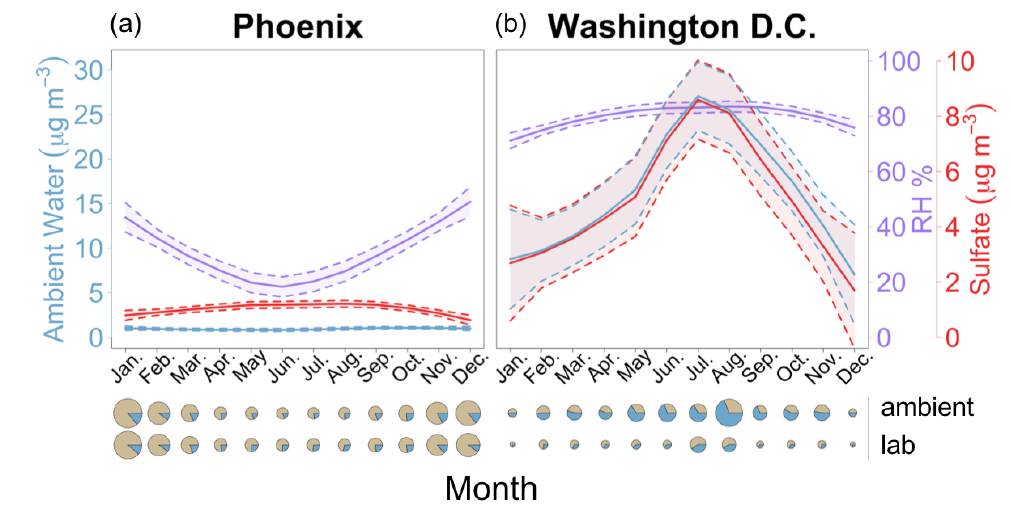
Figure 3. Mass concentrations of aerosol liquid water and particulate sulfate are abundant and positively associated in Washington D.C., and not Phoenix, AZ in 2004. 2004 monthly mean values of ambient water content, relative humidity, and sulfate ( a ) (left) Phoenix, Arizona, and ( b ) (right) Washington D.C. Each variable is presented as the mean (solid line) and 95% confidence interval (shaded area and dotted lines). Pie charts illustrate the monthly average dry mass (brown) and water fractions (blue) for each month in each city at ambient and lab conditions. Pie chart diameter is relative to the largest monthly average mass concentration of each city.